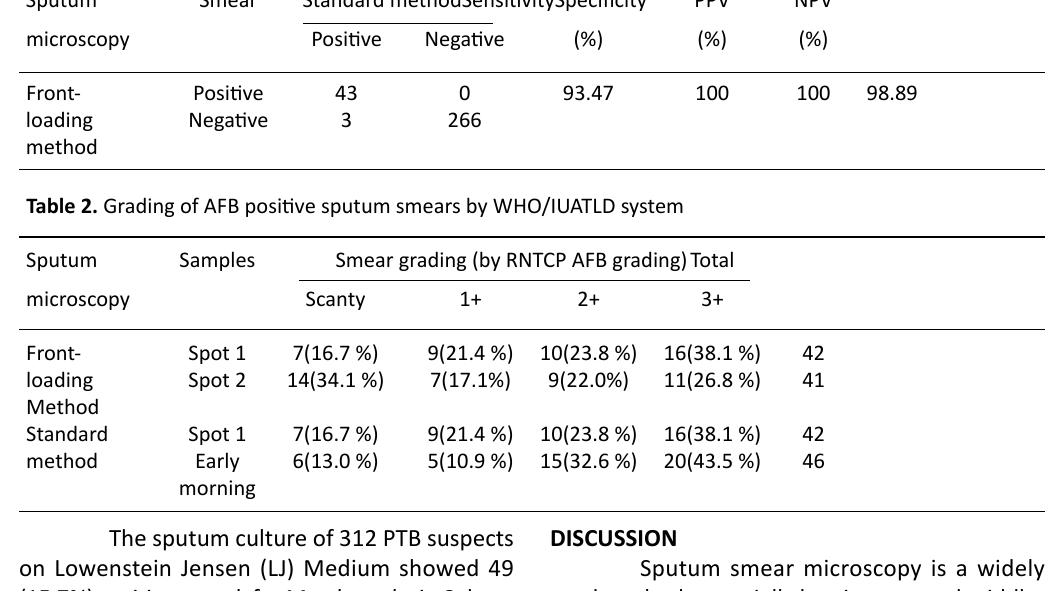
table 1. Comparison of standard method and front loading method of sputum microscopy Sputum Smear